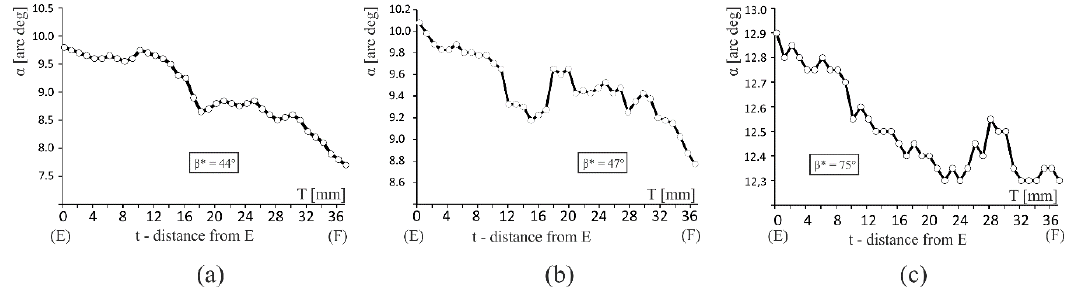
Figure 4. Examples of the α angle distribution along the T axis (Figure 1a) of an airfoil for blades obtained at the withdrawal rate of ( a ) 2 mm / min.; ( b ) 3 mm / min. and ( c ) 4 mm / min. t—distance from the E point—Figure 1a.